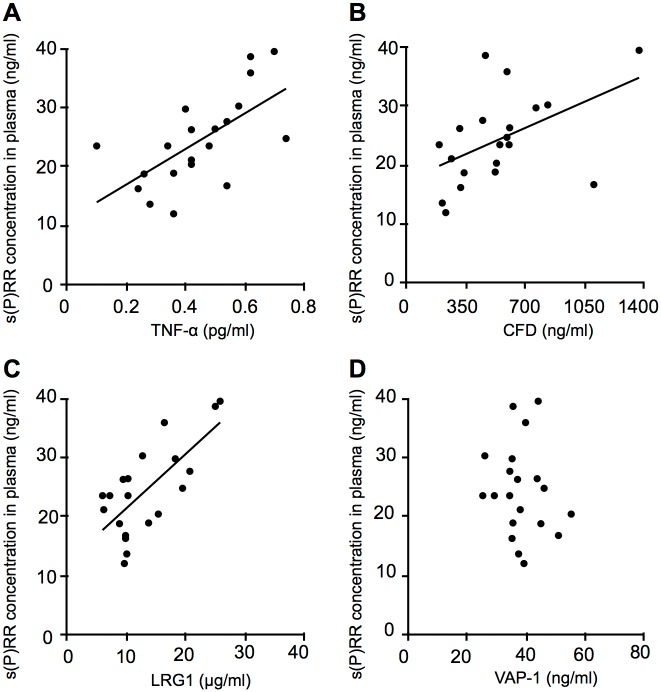
Correlations between s(P)RR and inflammatory mediators elevated in the plasma of PDR patients.Correlations between s(P)RR and inflammatory mediators TNF-α (A), CFD (B), LRG1 (C) and VAP-1 (D) in the plasma of patients with PDR (n = 20, Spearman rank correlation).